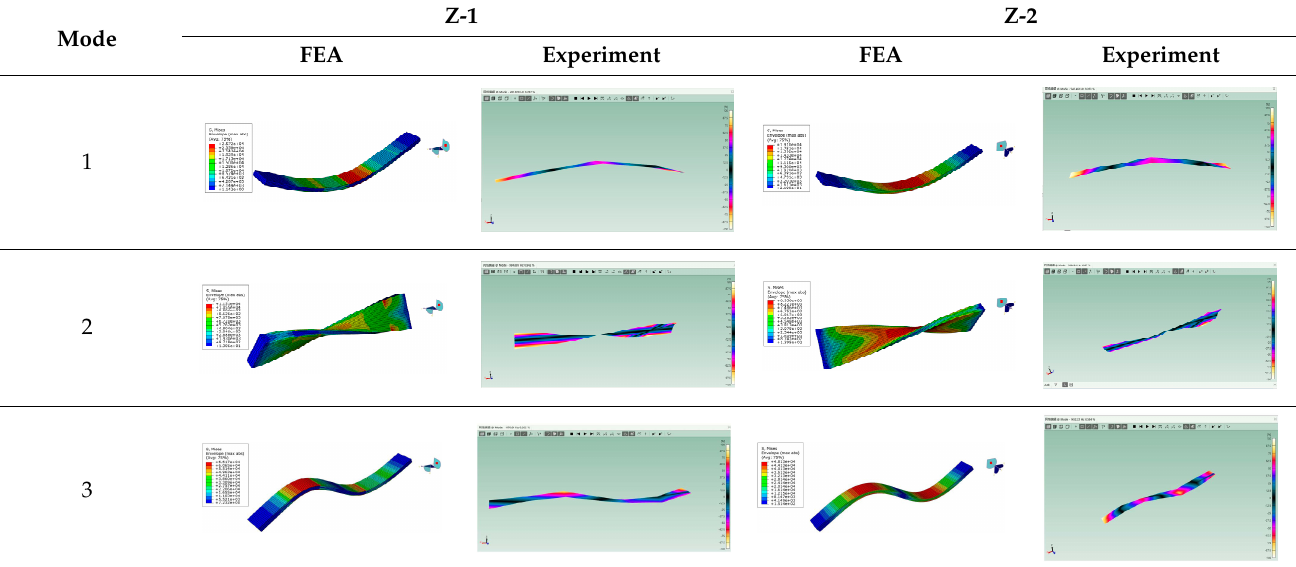
Table 8. Mode shapes of specimens.